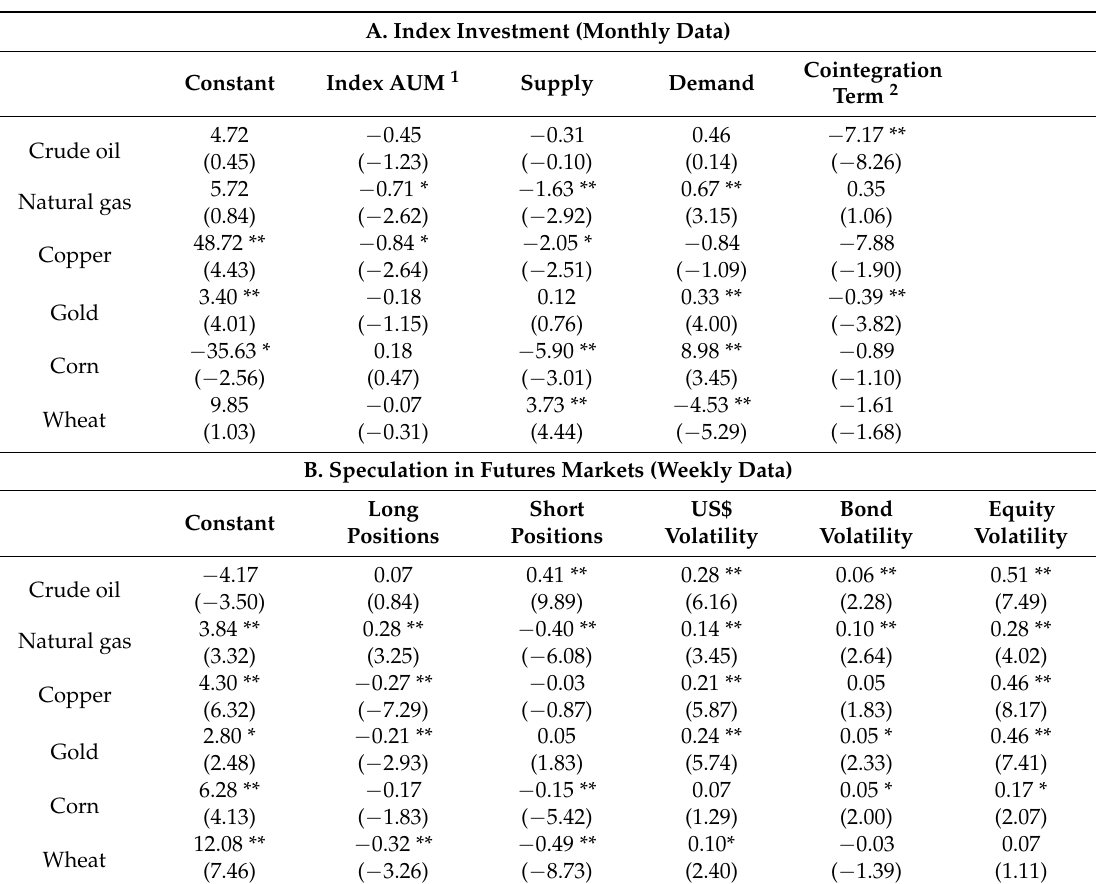
Table 7. Analysis of Financialization Impact on